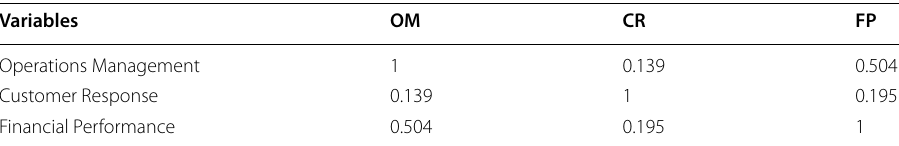
Table 6 Correlation analysis, Pearson’s correlation